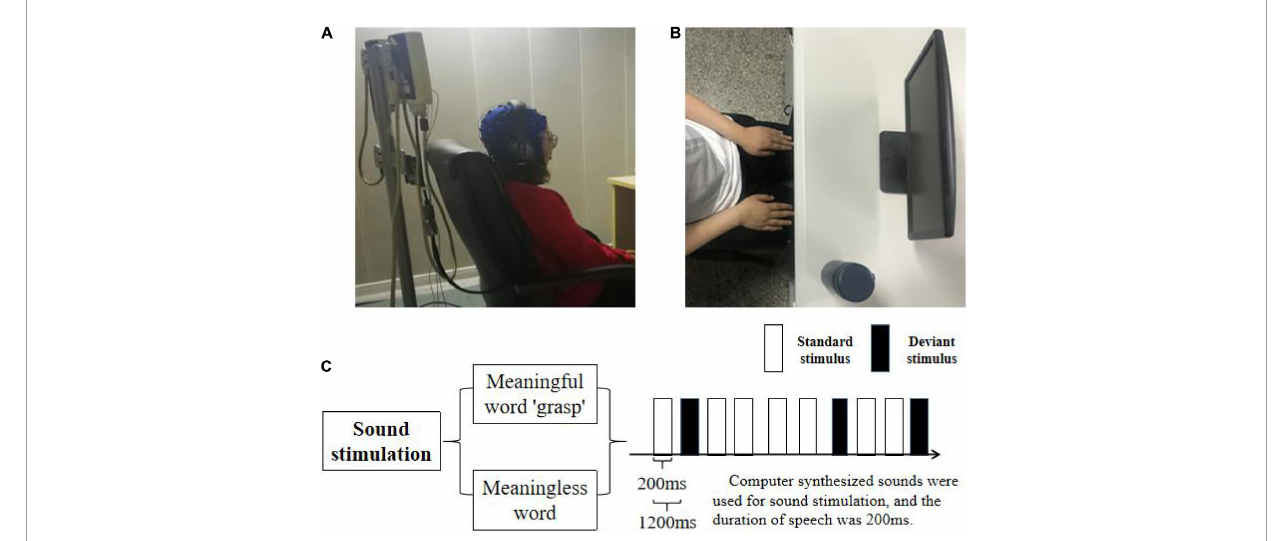
FIGURE1 Task design. (A) The picture of the experimental environment, the subjects kept sitting relaxed with their hands flat on their legs. (B) The top view of the experimental environment, the subjects are facing the display device, and the physical cup for right hand movement imagination is placed on the desktop and on the right side of the display. (C) Experimental flow diagram, the experiment was divided into two groups. The two groups used the same standard stimulus, and the deviation stimulus used verbs “grasp” and no verbs, respectively. The stimulating sound was composed by computer. The playing time was 200 ms and the interval was 1,200 ms.